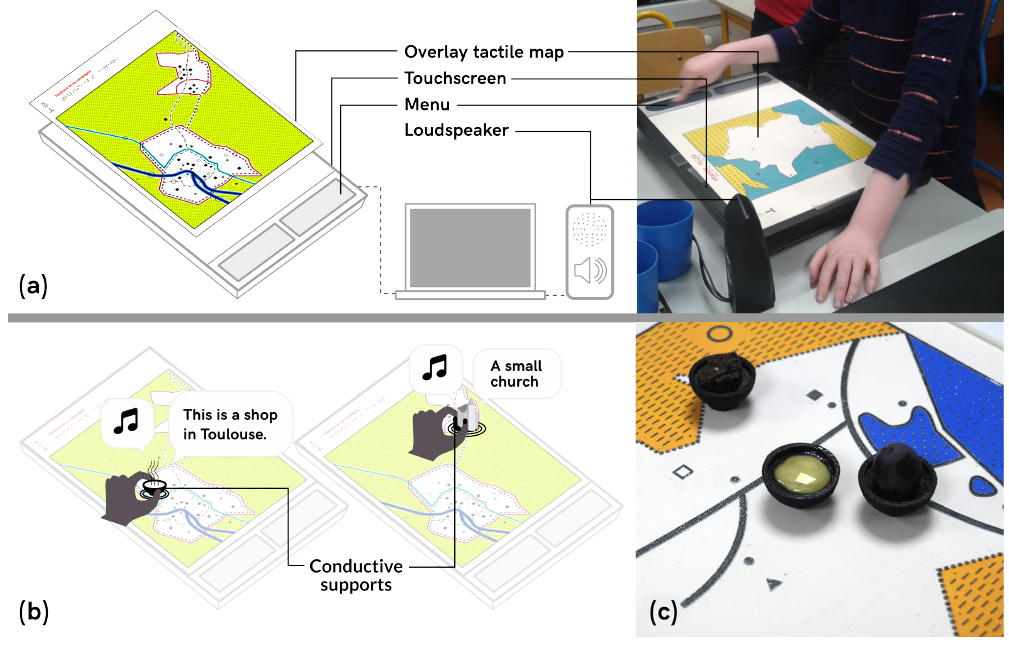
Figure 1. ( a ) the main setup of MapSense consists in a touchscreen, a tactile map overlay and loudspeakers. Double tapping on a map element triggers verbal audio output. ( b ) MapSense is used with Do-It-Yourself tangibles, placed on conductive supports recognized as touch events. Some tangibles are filled with smellable or tastable material. ( c ) on this screen size, three tangibles can be used at the same